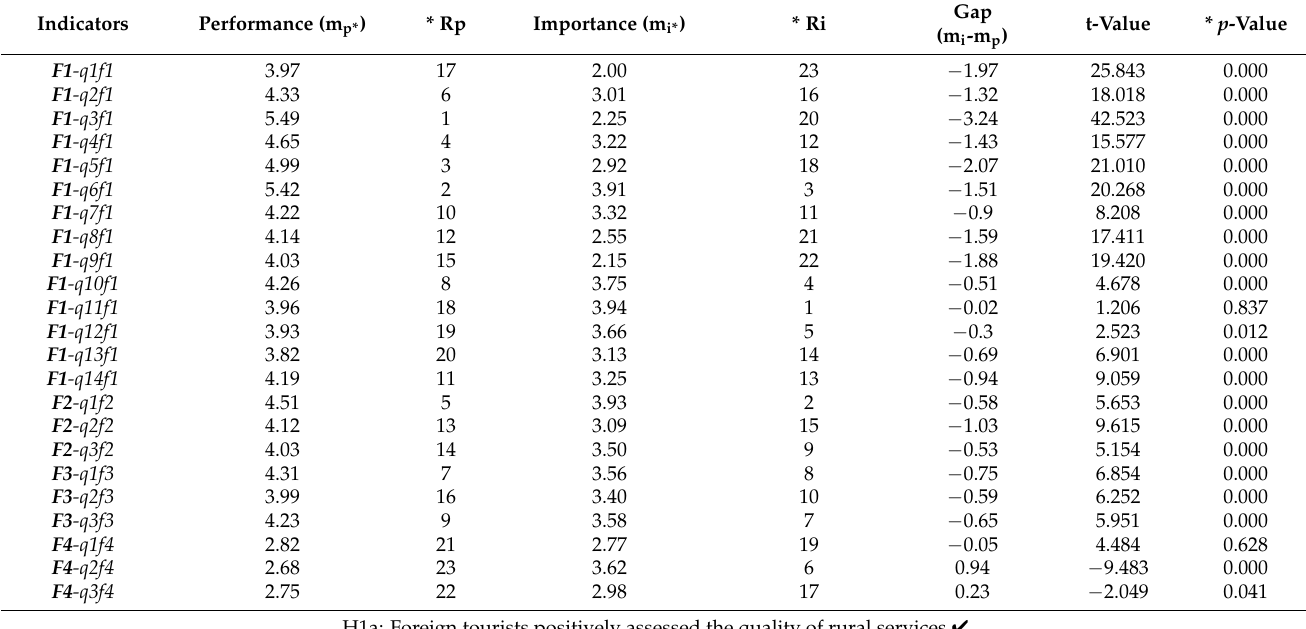
Table 2. Importance–performance analysis of the primary Table 2. Importance – performance analysis of the primary indicators.